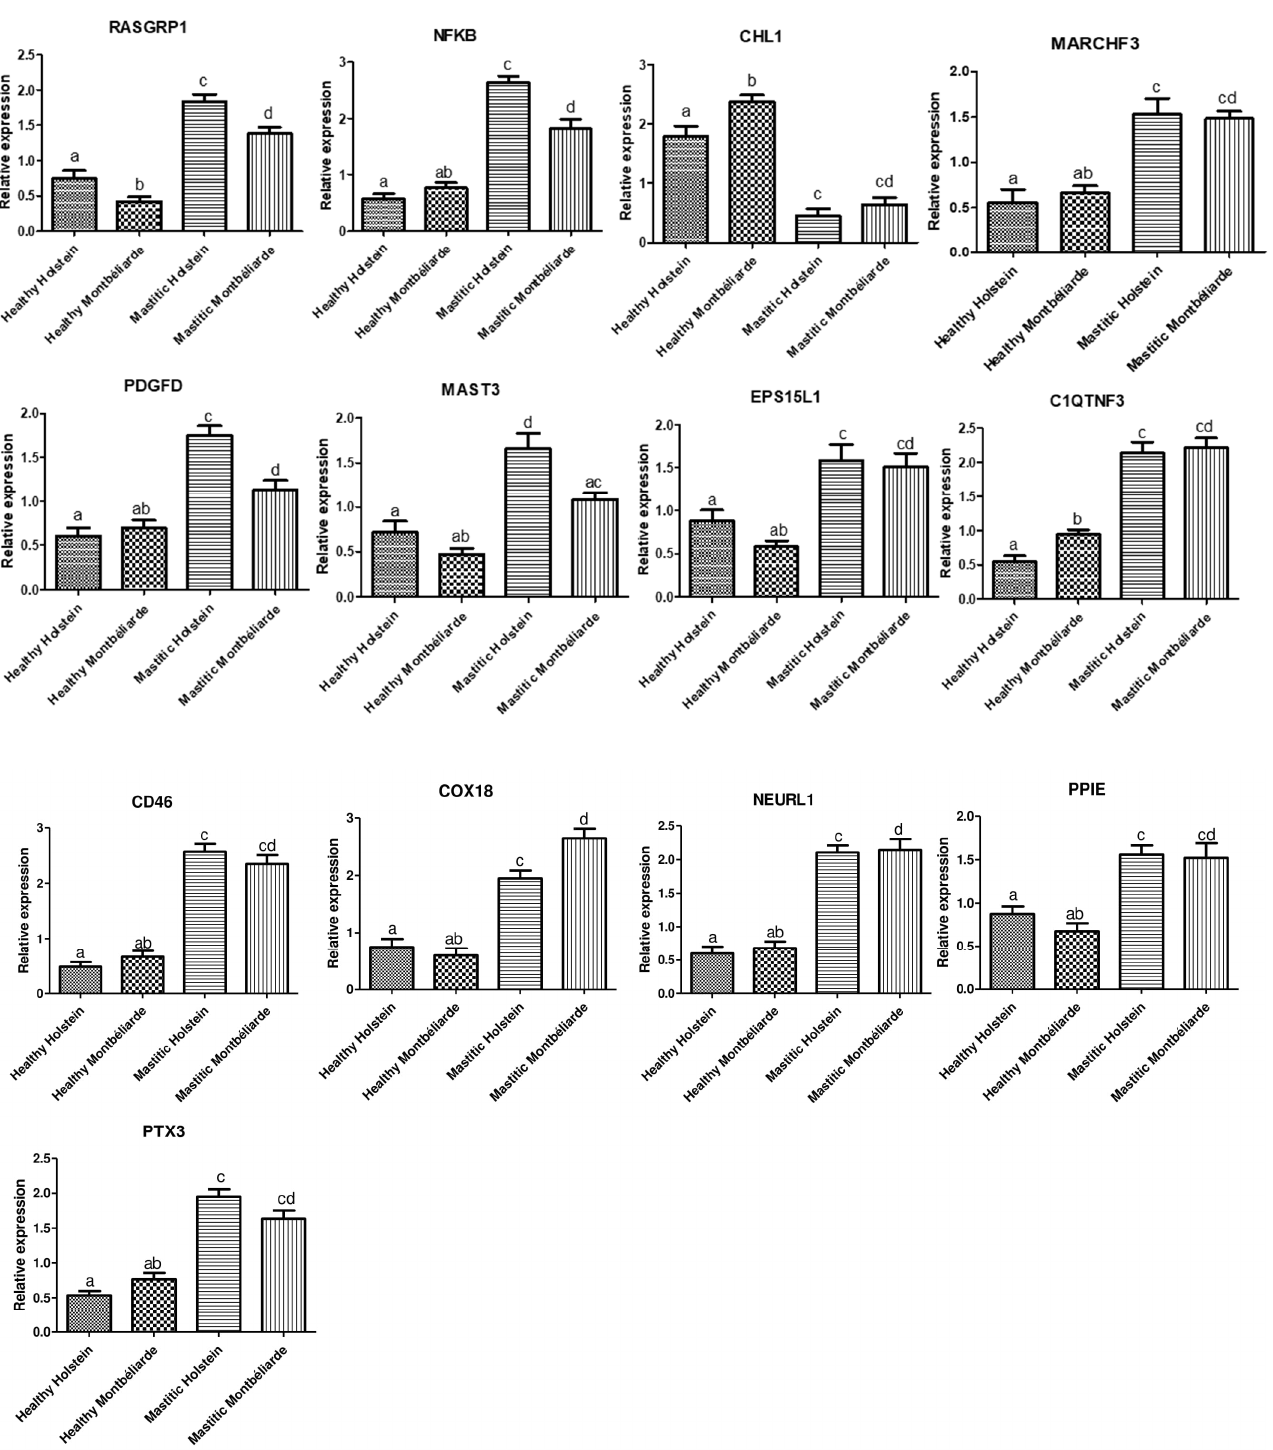
Figure 1. Comparative expression patterns of the genes RASGRP1 , NFkB , CHL1 , MARCH3 , PDGFD , MAST3 , EPS15L1 , C1QTNF3 , CD46 , COX18 , NEURL1 , PPIE , and PTX3 in healthy and mastitis affected Holstein and Montbéliarde dairy cows. a, b, c, d, ab, cd means small alphabetic letters show significance when p < 0.05.